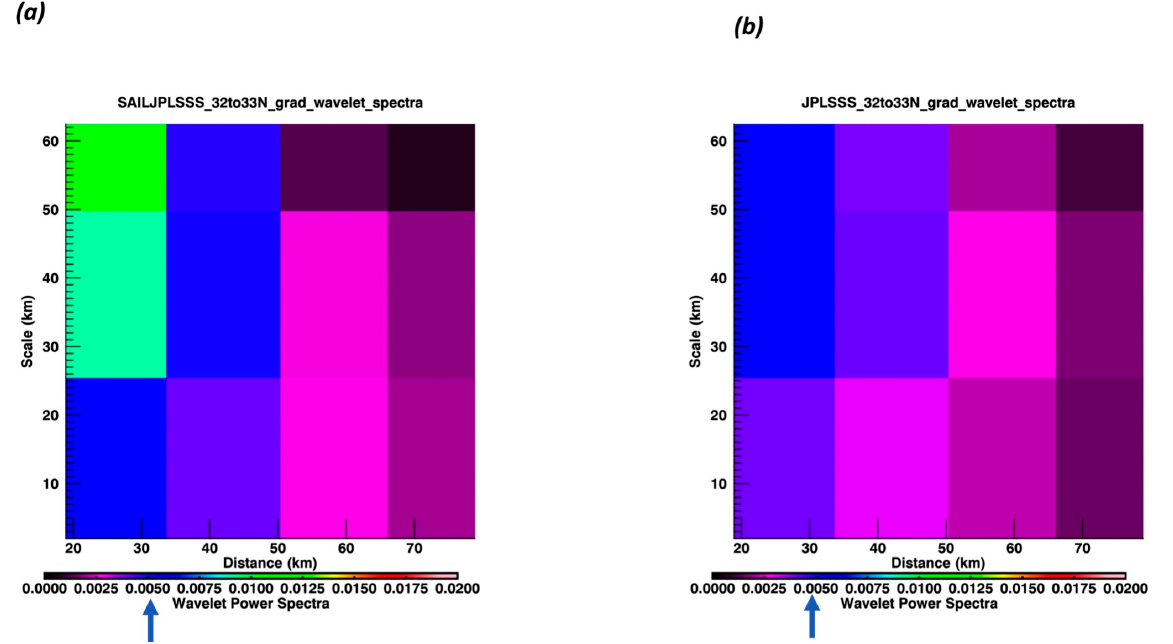
Figure 8. ( a , b ). Wavelet spectra from 32°N to 33°N for ( a ) SAILSSS and ( b ) JPLSSS. Arrows indicate the color associated with the 95% level of confidence.